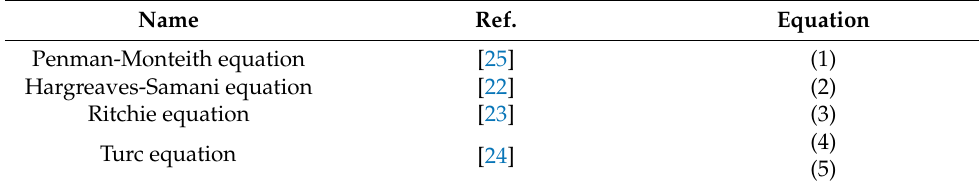
Table 1. Evapotranspiration